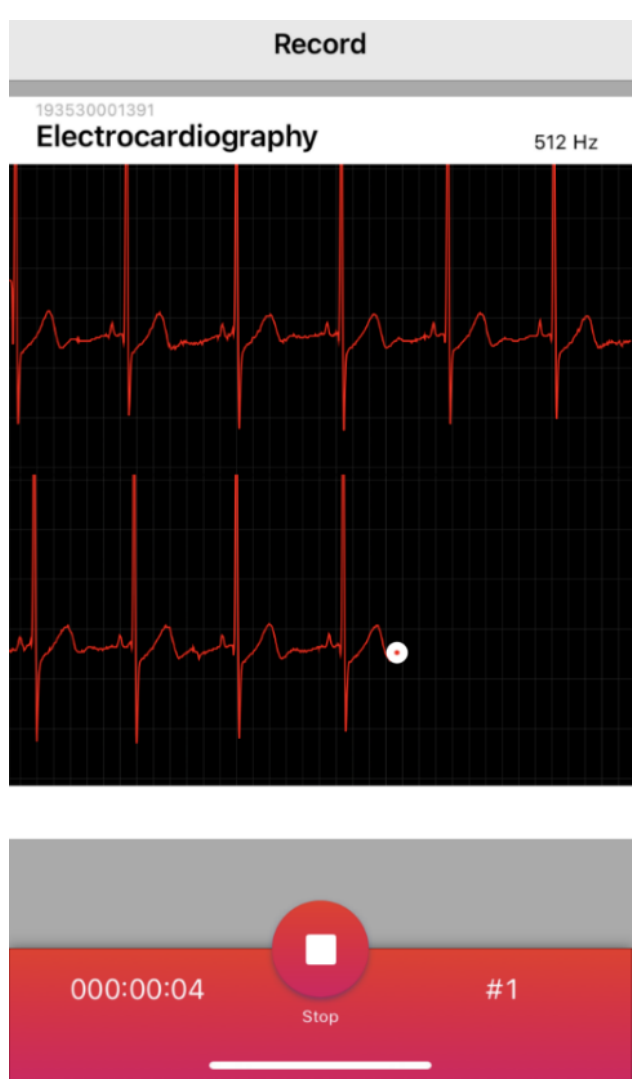
Figure 1. Real-time view of single channel ECG recorded (max. sampling rate: 512 Hz) with the chest belt sensor Movesense Medical displayed in the data logger app Movesense Showcase, here for iOS operating system.